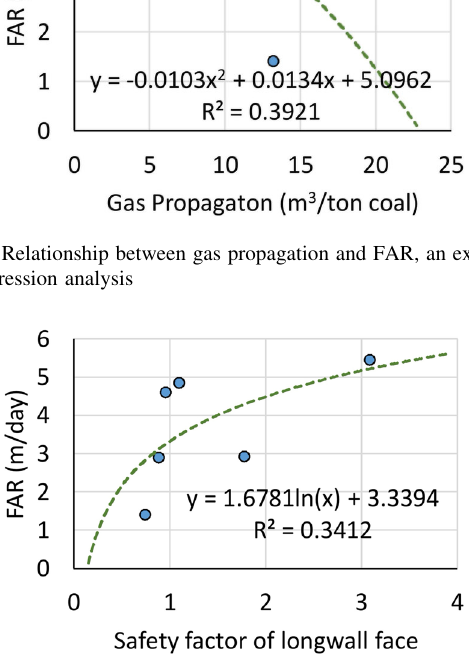
Fig. 10 Relationship between safety factor of longwall face and FAR, a linear regression analysis